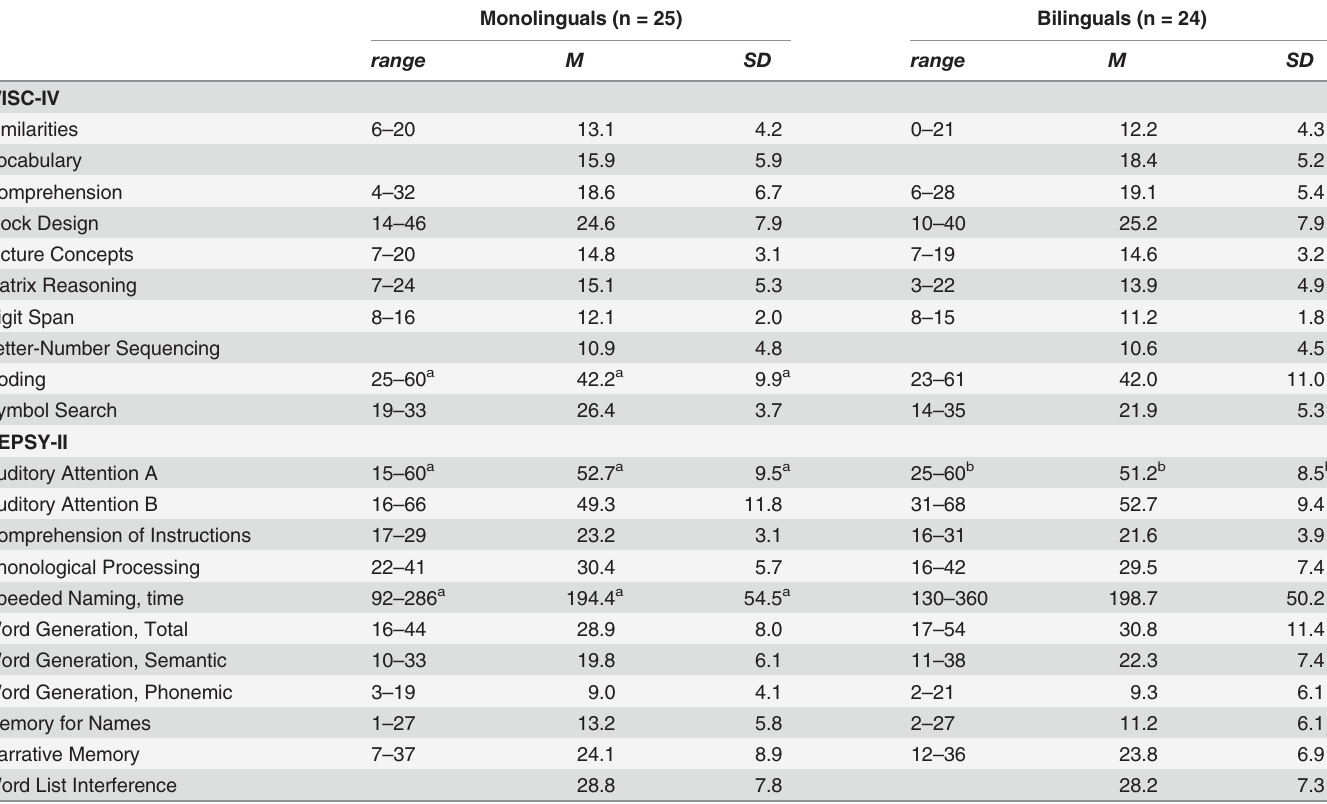
Table 4. Test Performance in Raw Scores of Monolinguals and Bilinguals in the younger